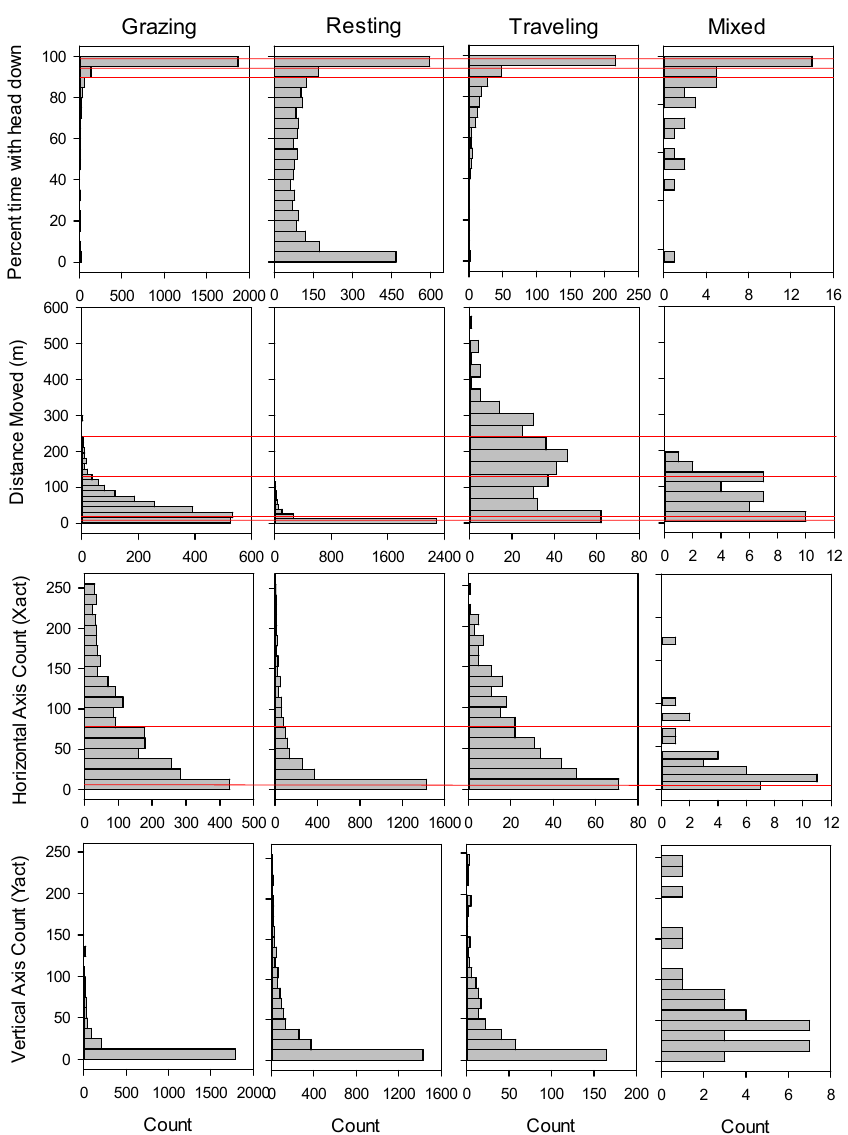
Figure 1. Frequency distributions of movement distances and activity sensor measurements collected at 5 minute intervals using Lotek 3300LR GPS collars on yearling steers in eastern Colorado, for each of four activity categories. The “mixed” category refers to 5 minute intervals where neither grazing, resting, nor traveling occurred for 50% or more of the interval. Red lines show thresholds identified by the final selected classification tree discriminating among the four activity categories (see Figure